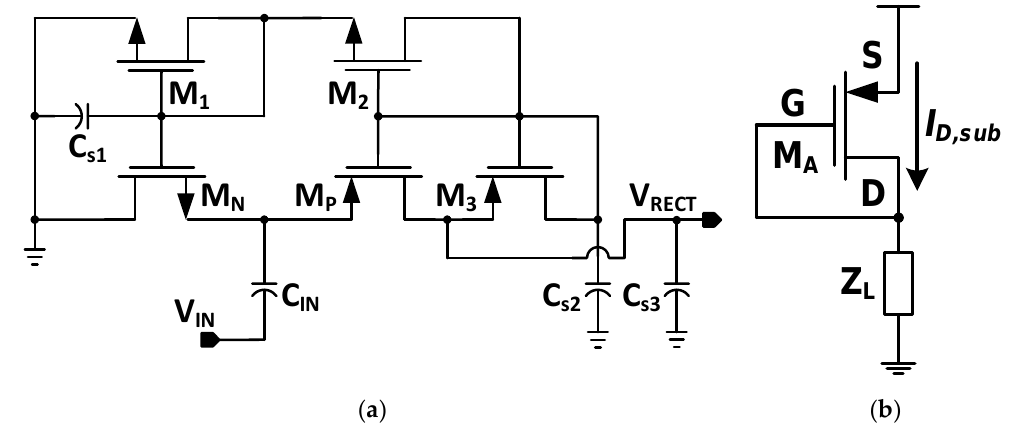
Figure 6. ( a ) Circuit diagram of the proposed rectifier. ( b ) Auxiliary transistor for producing optimum compensation voltage.